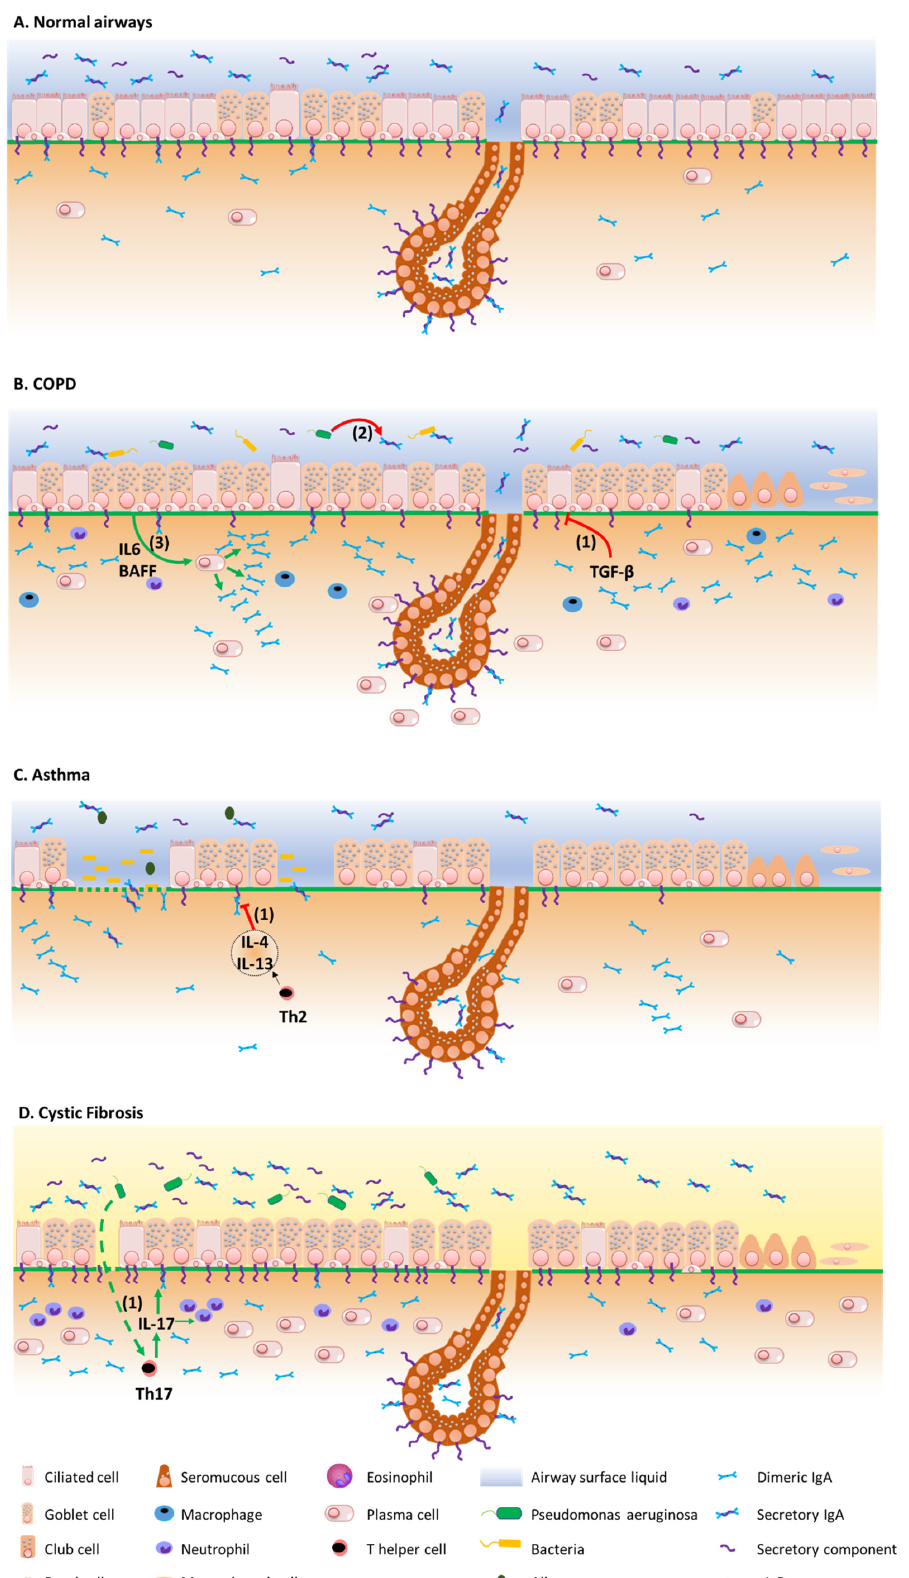
Figure 2. Overview of the pIgR/IgA system dysregulation mechanisms in chronic respiratory dis- eases. ( A ) pIgR/IgA system in airway homeostasis, at the epithelial surface and in submucosal